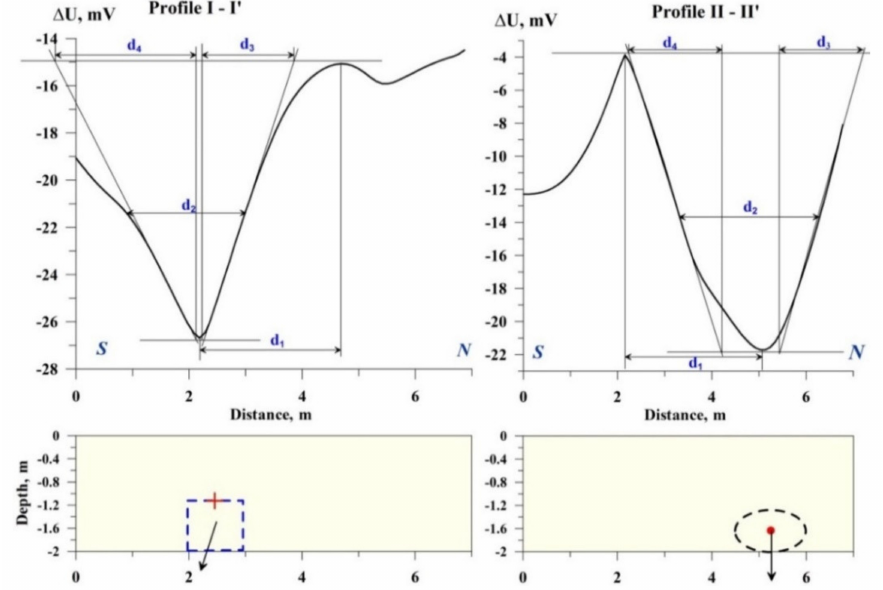
Figure 13. Quantitative analysis of anomalies I–I’ and II–II’ (see Figure 12) in the Banias site (northern Israel). The red cross indicates position of the center of upper edge, the bold red point testifies a position of HCC center, and the black arrows show direction of self-polarization